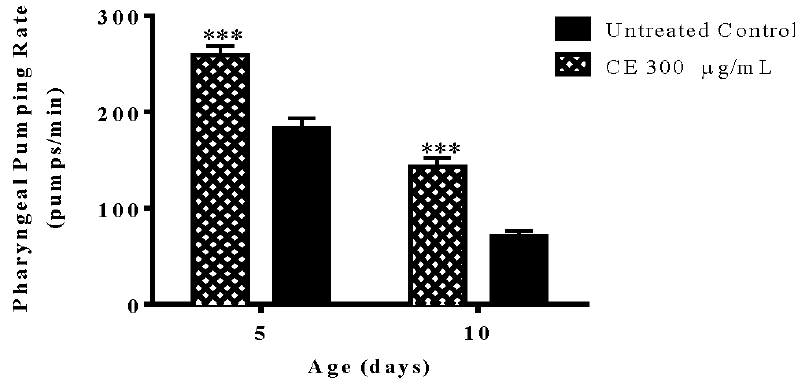
Figure 6. Pharyngeal pumping rate after treatment with C. spruceanum extract (CE). The treatment of wild type worms with 300 μ g/mL CE significantly attenuated the age-associated decline in the pharyngeal muscle function. Data are presented as mean ± SEM. *** p < 0.001 related to the control by a two-way ANOVA.